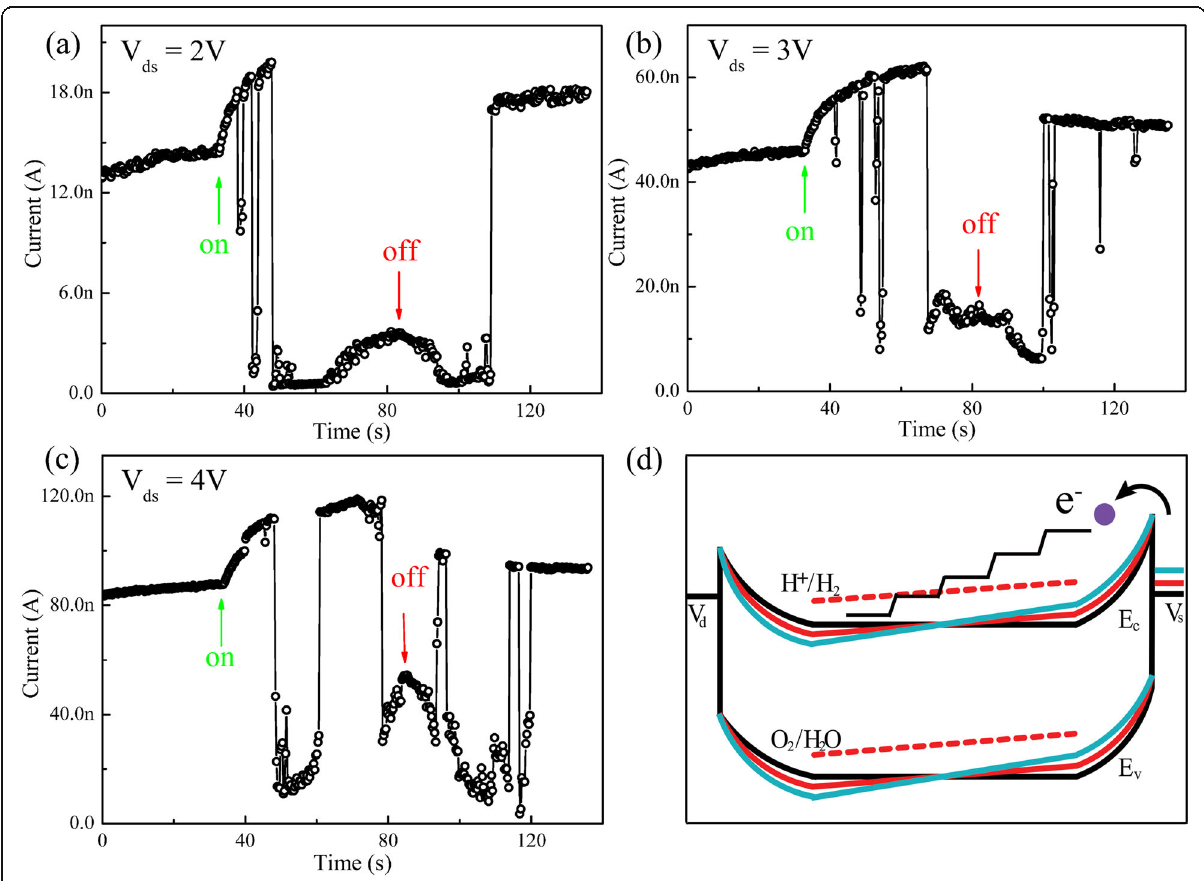
Fig. 4 Typical I-T curves of a device recorded on different biases (2 V ( a ), 3 V ( b ), 4 V ( c )) with laser (445 nm, 500 mW) on and off at 50% RH. d Schematic band structures of the Au/h-WO 3 NW/Au device under different bias voltages and the non-ballistic transport of the injected